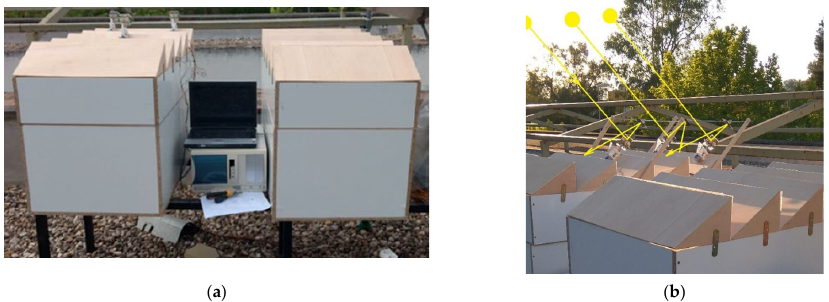
Figure 15. Scale models place outdoors. ( a ) Scale model arrangement and data acquisition system ( b ) Solar rays’ trajectory.